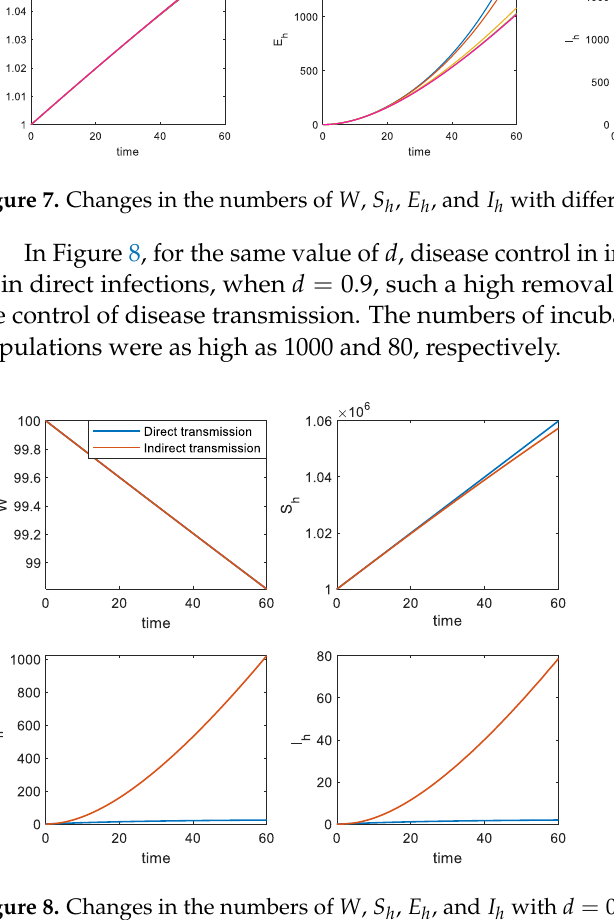
Figure 8. Changes in the numbers of W , S h , E h , and I h with d = 0.9 in model 1 (direct transmission) and 2 (indirect transmission).